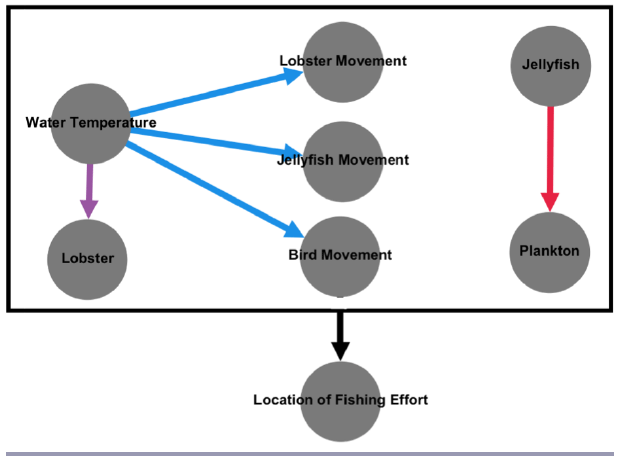
Fig. 5 . Network depicting fisherman’s description of indicators of seasonal patterns in the spatial distribution of lobster, and the relationship with spatial distribution of fishing effort, including four types of relationships (purple = species abundance or distribution; blue = species behavior; red = food web; black =